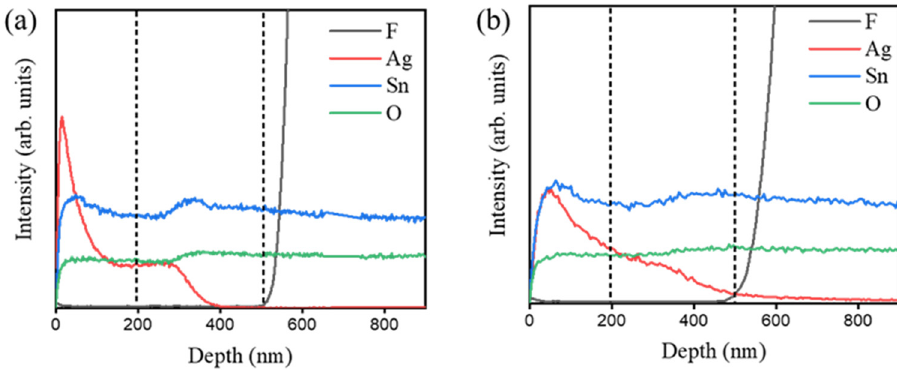
Figure 6: SIMS depth pro fi les of representative thin fi lm samples: ( a ) SA200 and ( b )